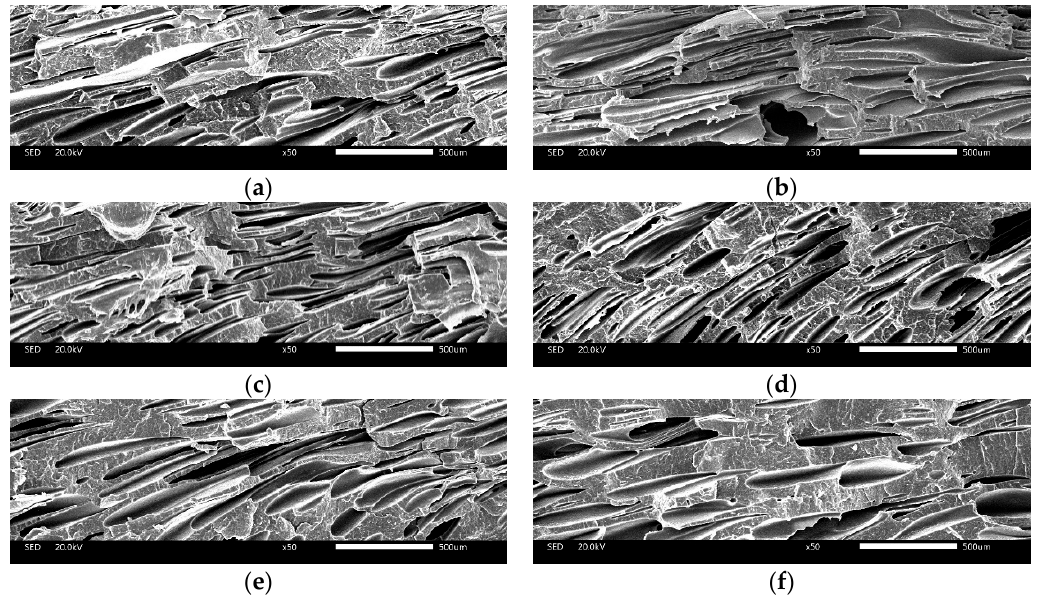
Figure 20. The cell structure of the transition layer of parallel sections with different contents of nano ‐